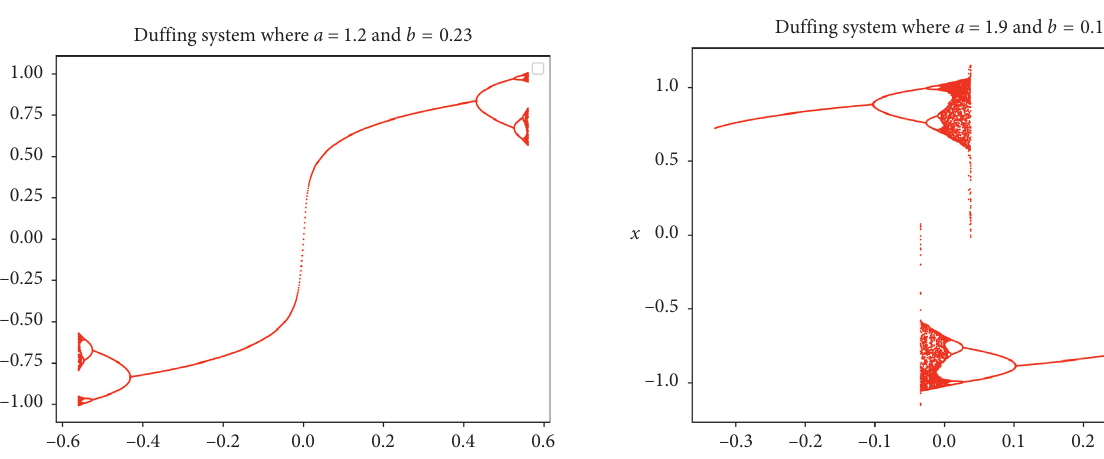
Figure 22: Bifurcation diagram of β